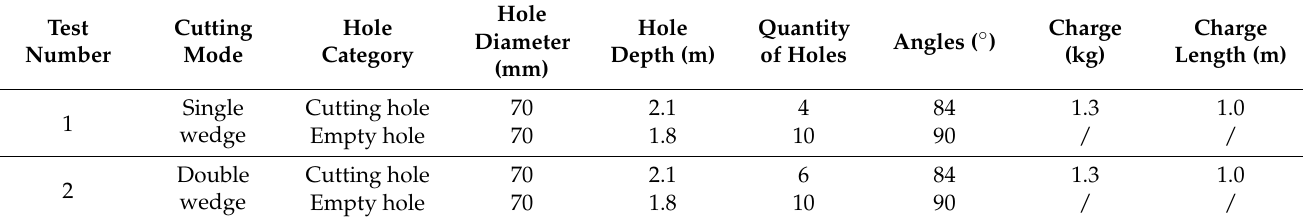
Table 2. Test parameters of cutting